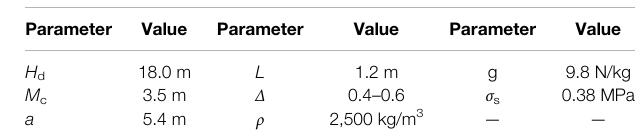
TABLE 2 | Parameters for calculating the fi lling thickness of the key bearing